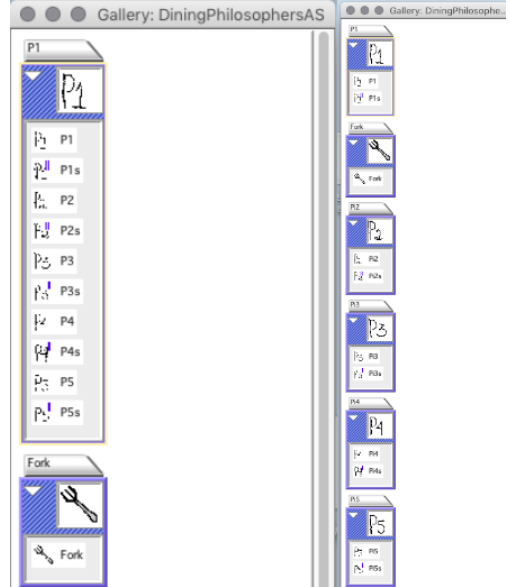
Fig. 1. Example of distinct representations of a Philosopher on AgentSheets; in the left, there is one agent with depictions for instances of philosophers and their state; in the right, each philosopher has its own agent on AgentSheets.